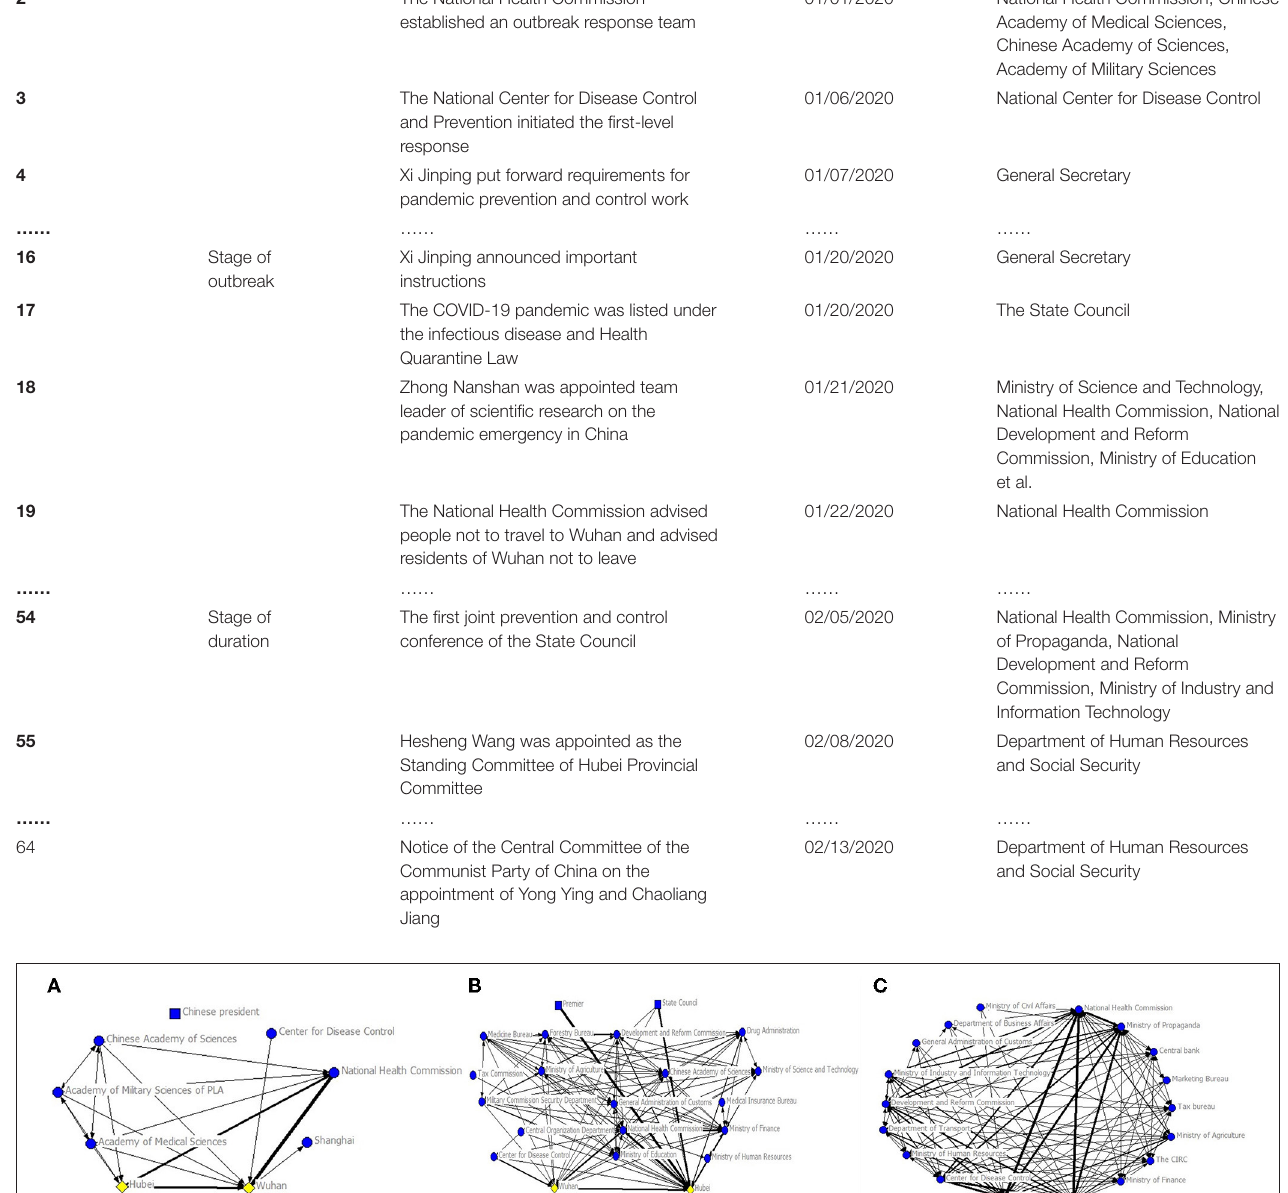
FIGURE 2 | (A–C) Response of the central government in three stages.